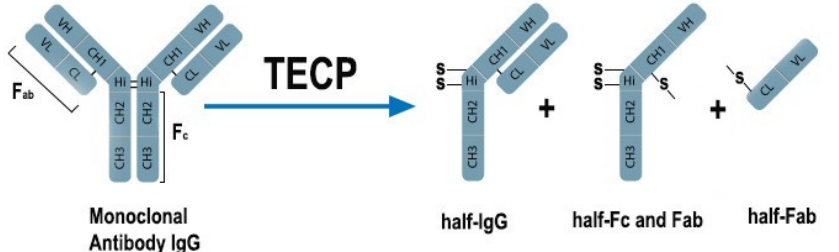
Figure 1. Illustration of the enzymatic reduction of the monoclonal antibody IgG by the disulphide- bridge-bond-breaker TECP (tris (2-carboxyethyl) phosphine hydrochloride) [63].